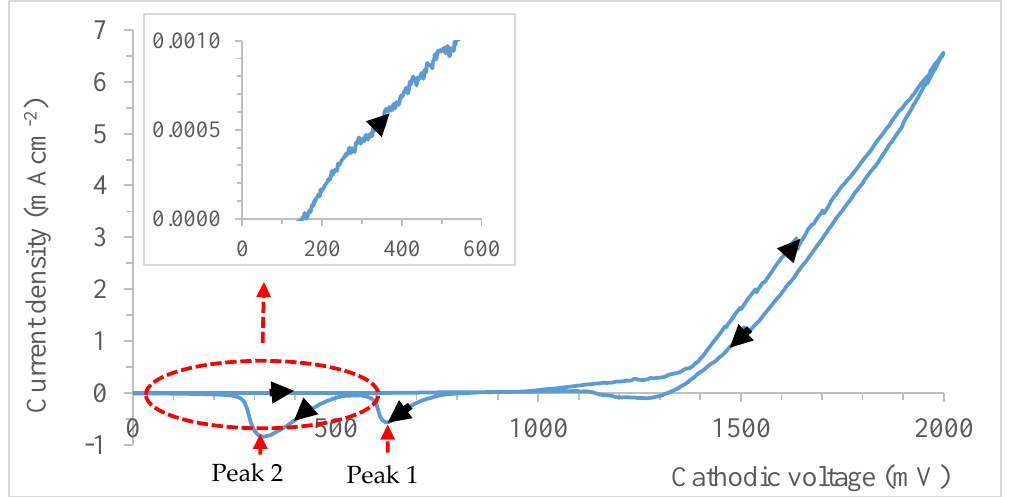
Figure 2. Typical cyclic voltammogram of an aqueous electrolyte at 85 ◦ C containing 1.5 M Cd(NO 3 ) 2 · 4H 2 O and 0.0002 M TeO 2 in 400 mL of DI